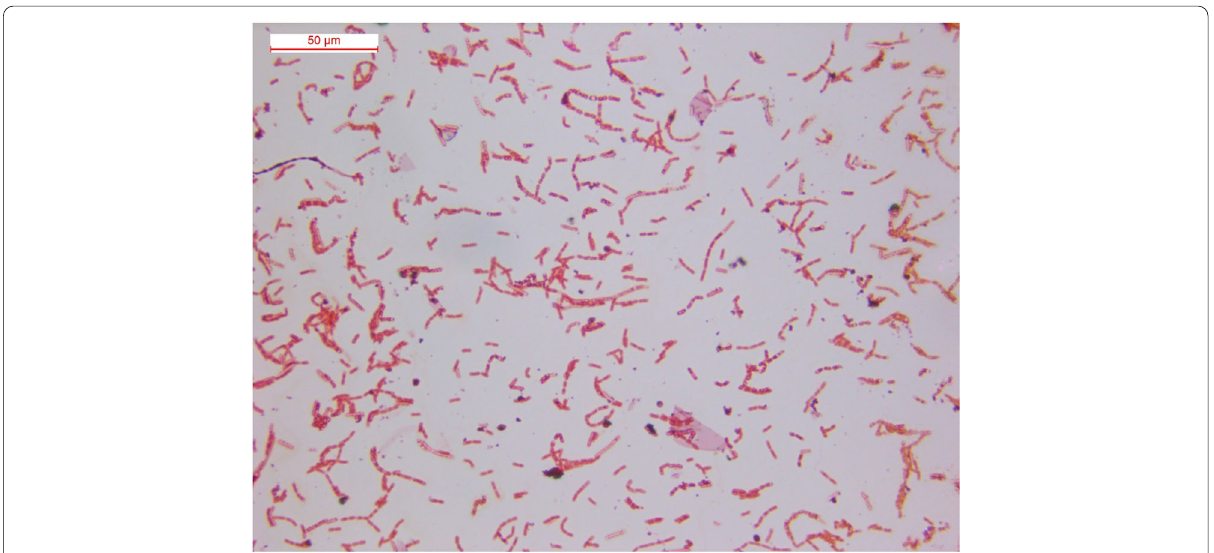
Fig. 2 A photomicrograph of Bacillus megaterium or B. aryabhattai taken from a contaminated ash shoot culture. A film of the contaminating bacteria was air-dried, and heat fixed before being stained with 2% aqueous safranin for 15 s, washed with distilled water and air dried for ~ 15 min. The stained bacterial film was examined using a Leica DM750 microscope and photographed with the attached Leica DFC425C microscope camera via Leica Application Suite version 4.9 software, c/o Steve Hendry of